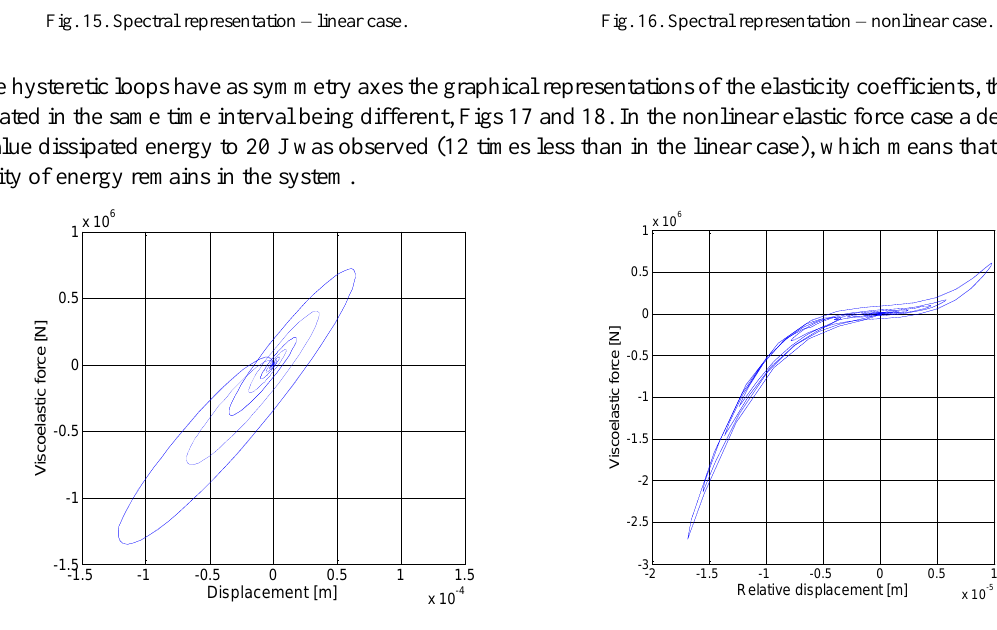
Fig. 17. Hysteretic loop: Llinear case, W = 256 J. Fig. 18. Hysteretic loops: Nnonlinear case, W = 20